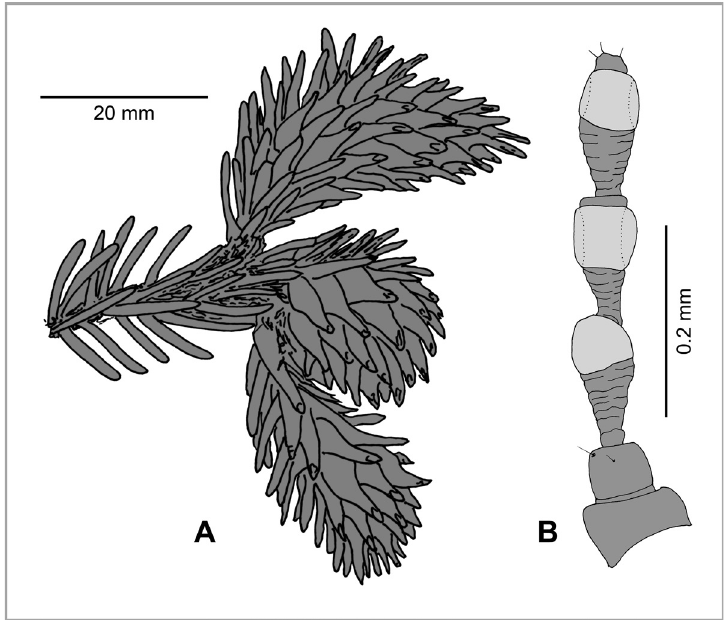
Fig. 4. Pineus (Pineus) orientalis (Dreyfus, 1889). A . Gall on Picea orientalis (after Carter 1976, redrawn). B . Antenna of gallicola (after Annand 1928, modified).